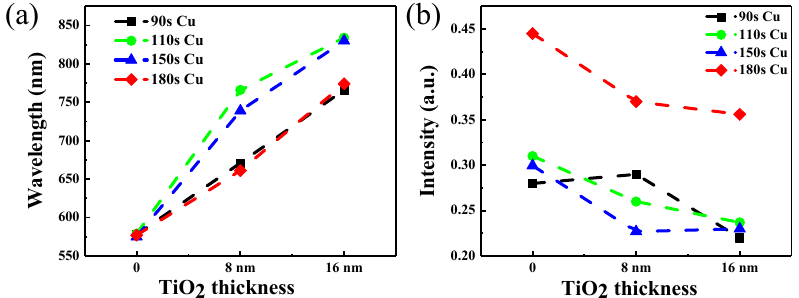
Figure 5. ( a ) The change of absorbance peak position of copper nanoparticles covered by TiO 2 of different thickness, ( b ) the change of the peak absorbance position of copper nanoparticles covered by TiO 2 of various thicknesses.